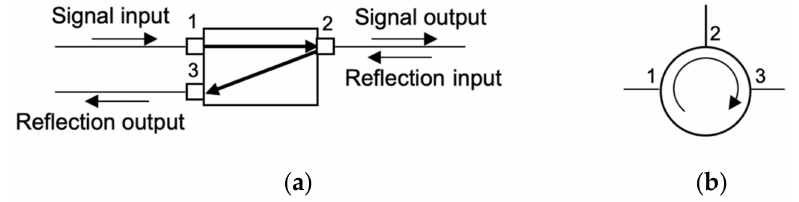
Figure 5. 3-port optical circulator. ( a ) the basic function, ( b ) symbolic